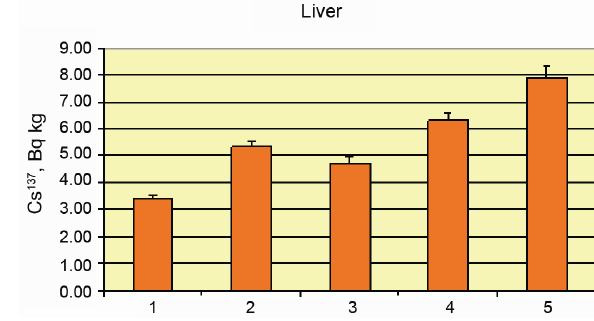
137 Cs in fox bone tissues: